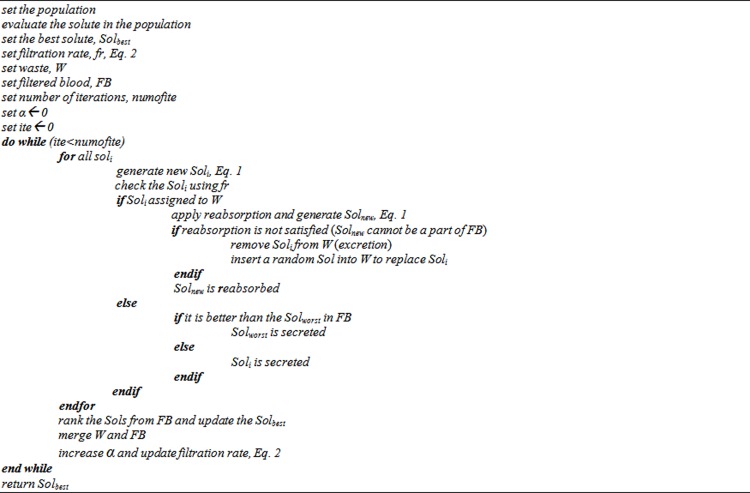
Pseudocode of KA.